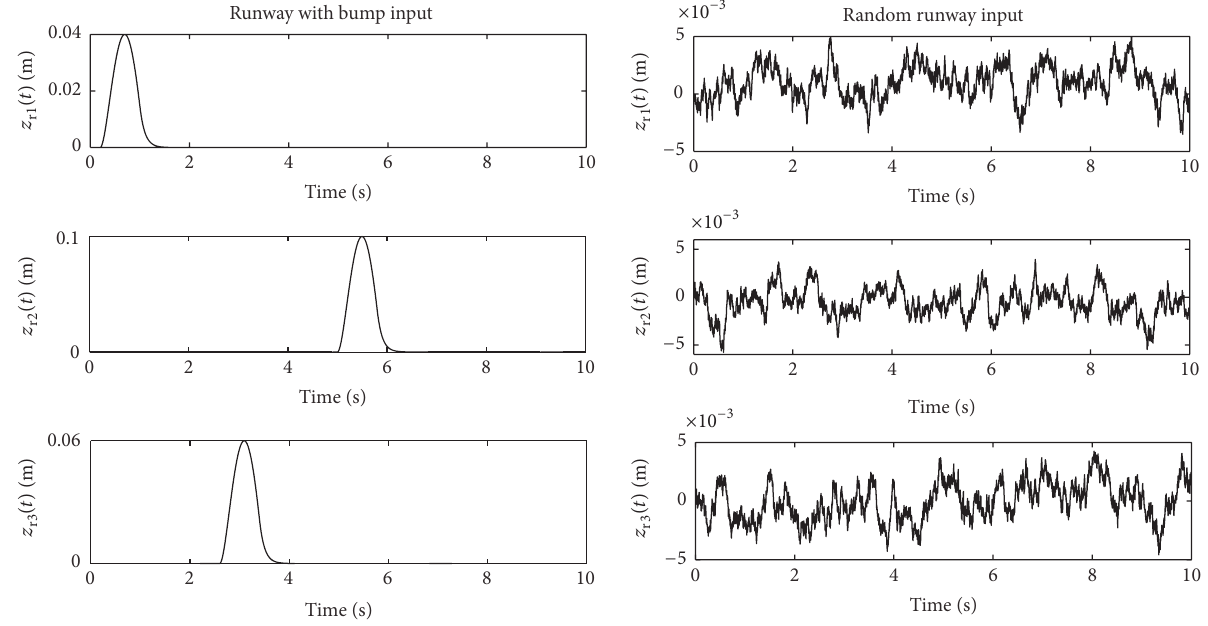
Figure 3: Bump and random runway disturbance inputs.